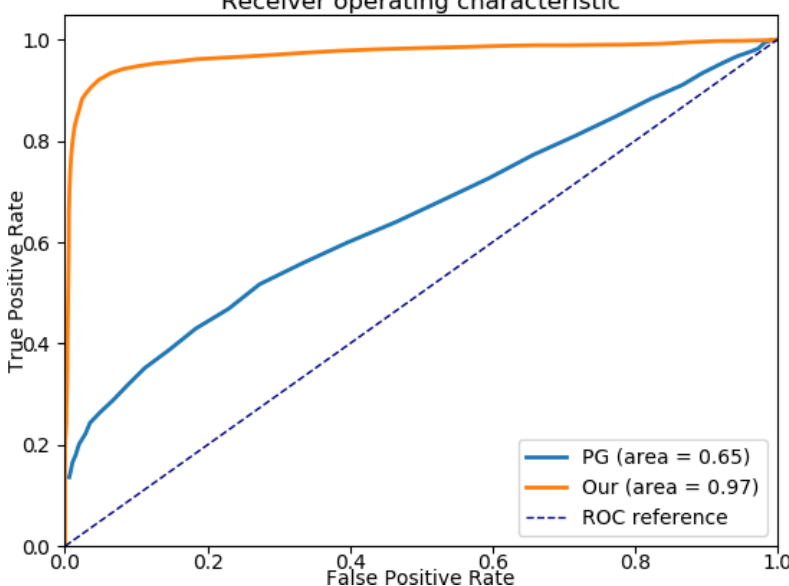
Figure 7. ROC curves for Dutta’s method and our framework. The area under their respective curve represent the overall location success rate.